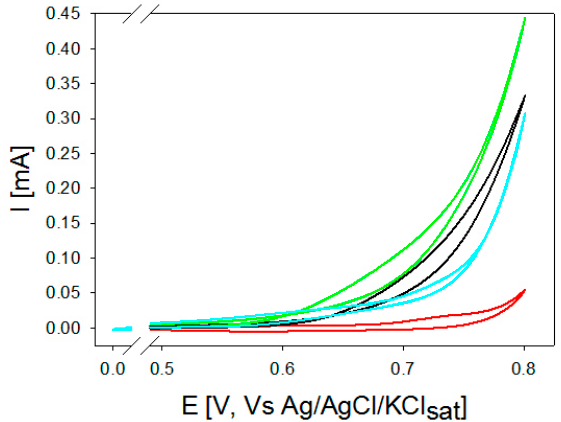
Figure 3. Cyclic voltammetry curves recorded on a steel AISI 316L WE. 50 mV/s potential scan rate, Pt sheet as CE and Ag/AgCl/KCl sat as RE. KOH 0.1 M aqueous solution is the base electrolyte. D -(+)-glucose concentration: (red) 0 mM, (light blue) 1 mM, (green) 10 mM, (black) 100 mM.